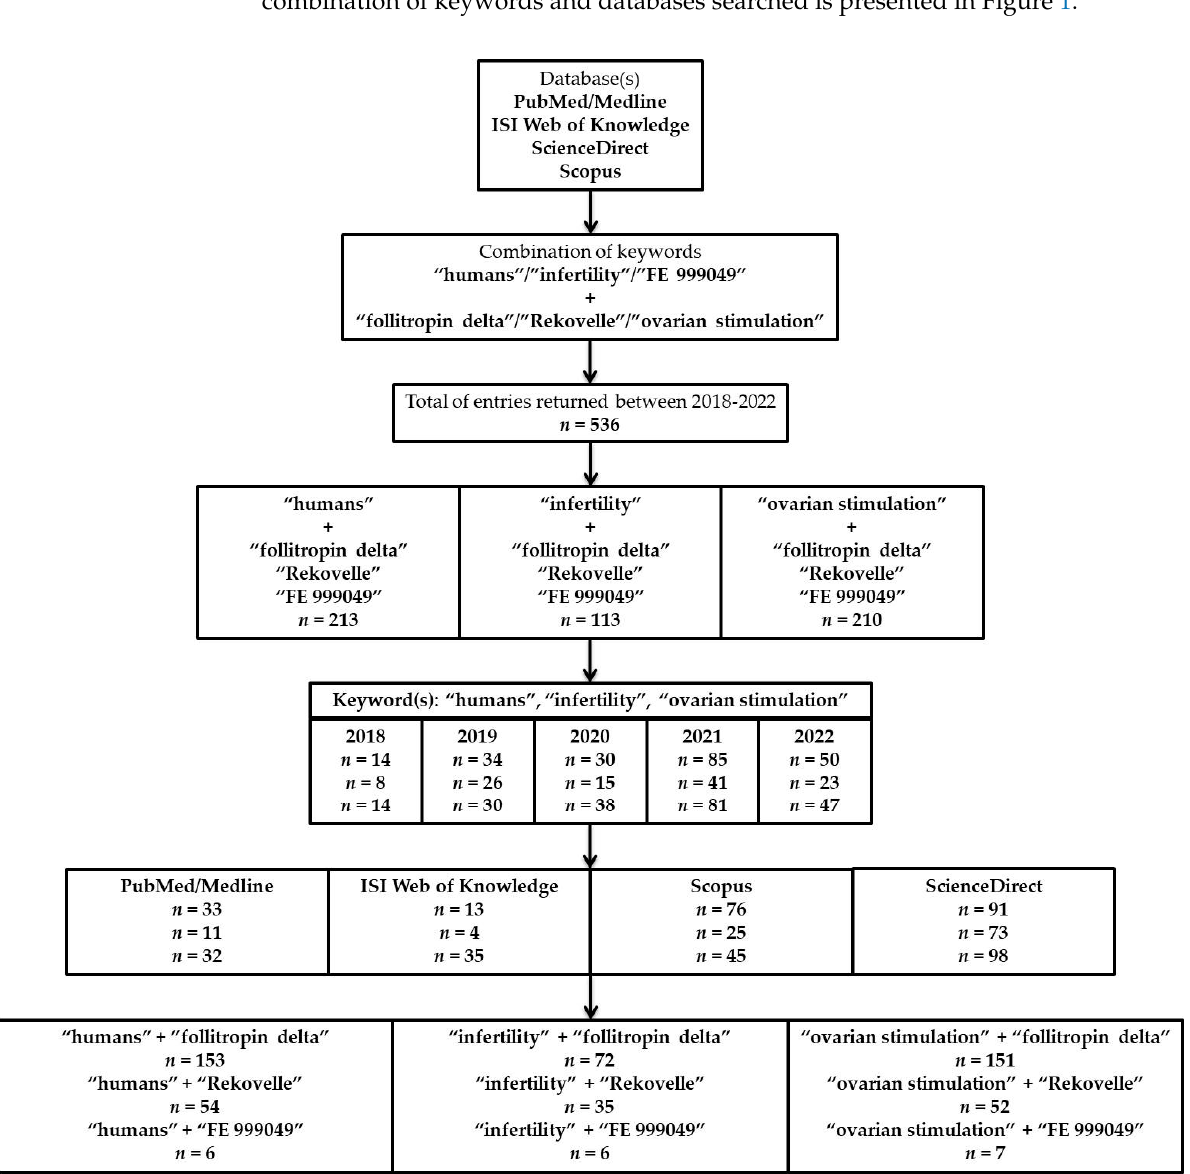
Figure 1. A flowchart of the study design, strategy, studies, and results that were included in the manuscript.